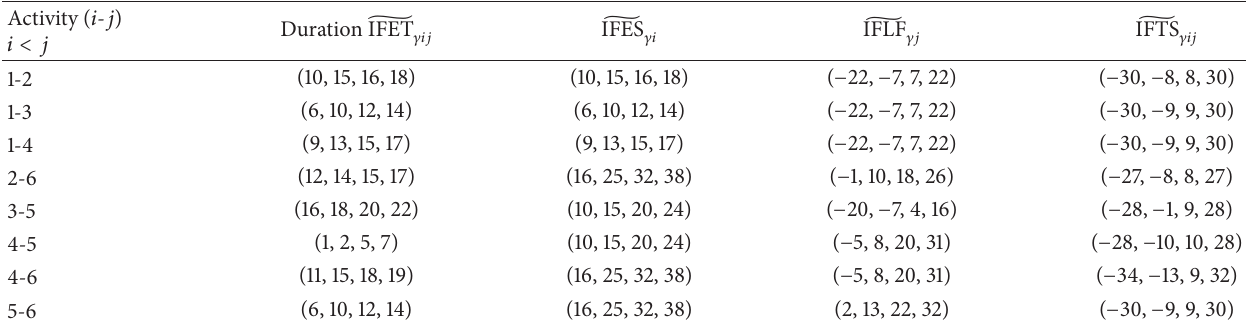
Table 3: Total slack (Atanassov) intuitionistic fuzzy time for each activity in an (Atanassov) intuitionistic fuzzy project network and critical path for nonmembership function.